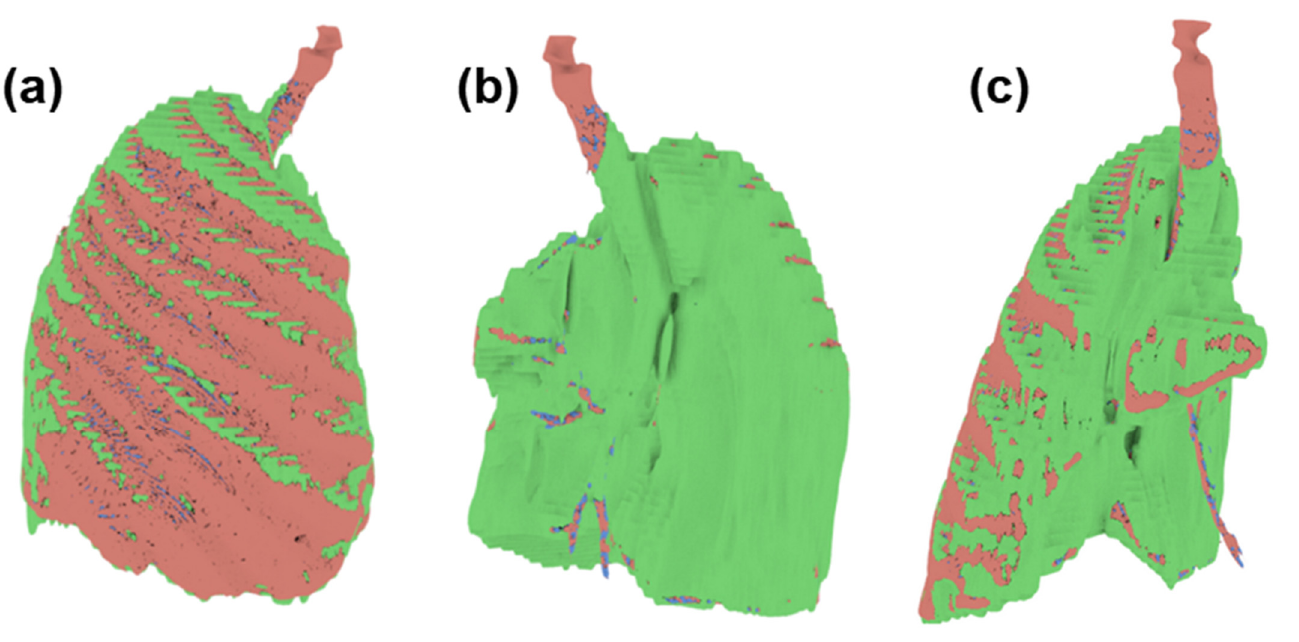
Figure 12. Superimpose of the tumor volume obtained from the three software ( a ) Front view ( b ) Back view ( c ) Side view.